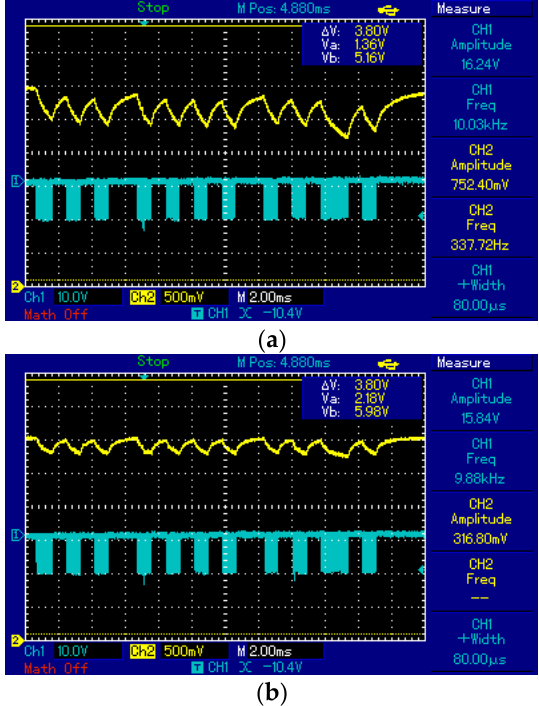
Figure 6. The indoor solar panel responses for ( a ) a small solar panel with dimensions 3.6 × 2.6 × 0.1 cm and ( b ) a large indoor solar panel with dimensions 7.5 × 5.3 × 0.1 cm.